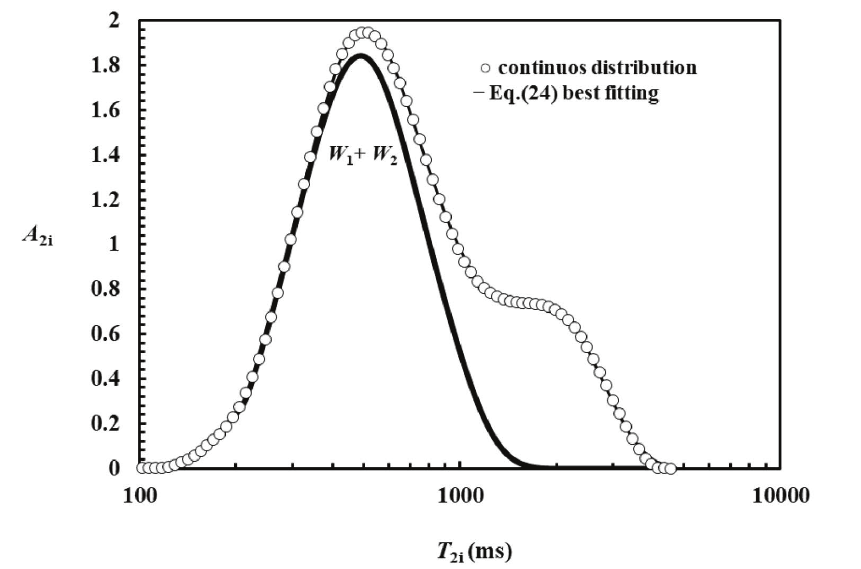
Fig. 6 – Continuous relaxation distribution (A of Tables 1 and 2. The solid thick line represents the cleaned relaxation distribution (sum of W and W ), deprived by the effect of the external water (W 1 2